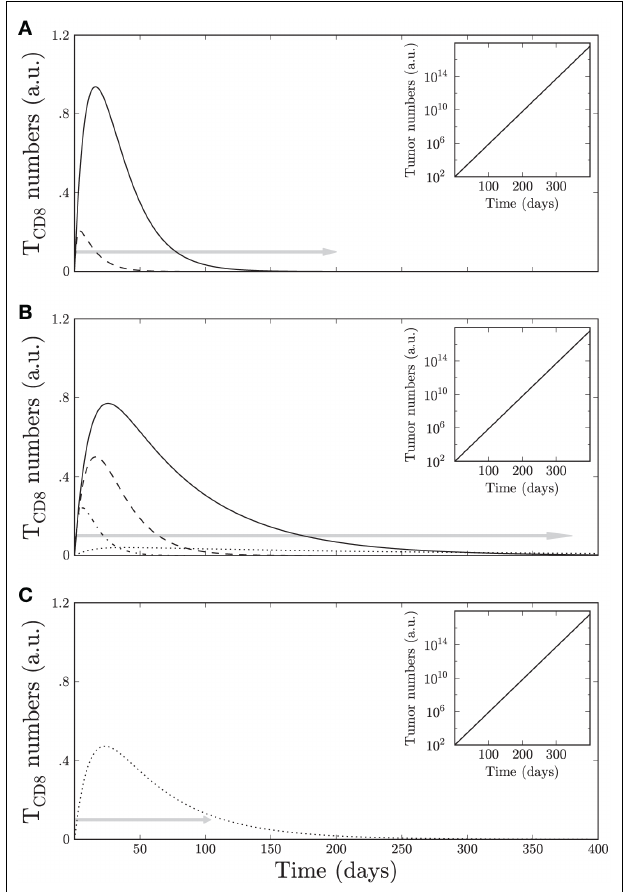
FIGURE 6 | SimulatedT CD8 s response in (A) pancreatic tumors, (B) osteosarcomas, and (C) brain tumors. Y -axis depicts the number ofT CD8 s in arbitrary units and x -axis depicts the time in days. Site I-specificT CD8 s is shown with a dashed line,T II/III with a dash-dot line, site IV-specificT CD8 s with a solid line, andT V with a dot line. Light gray arrows show the average lifespan of mice. All cases show a sequential loss ofT CD8 cells against different sites.The insets indicate tumor growth.